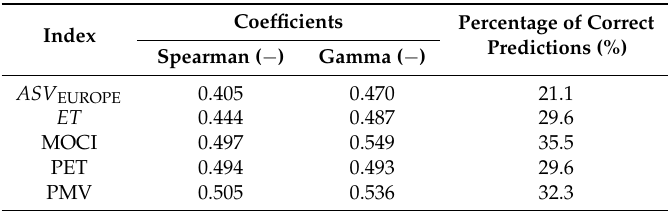
Table 3. Total percentage of correct predictions and correlation coefficients with respect to the values predicted by the indices and the votes given by the